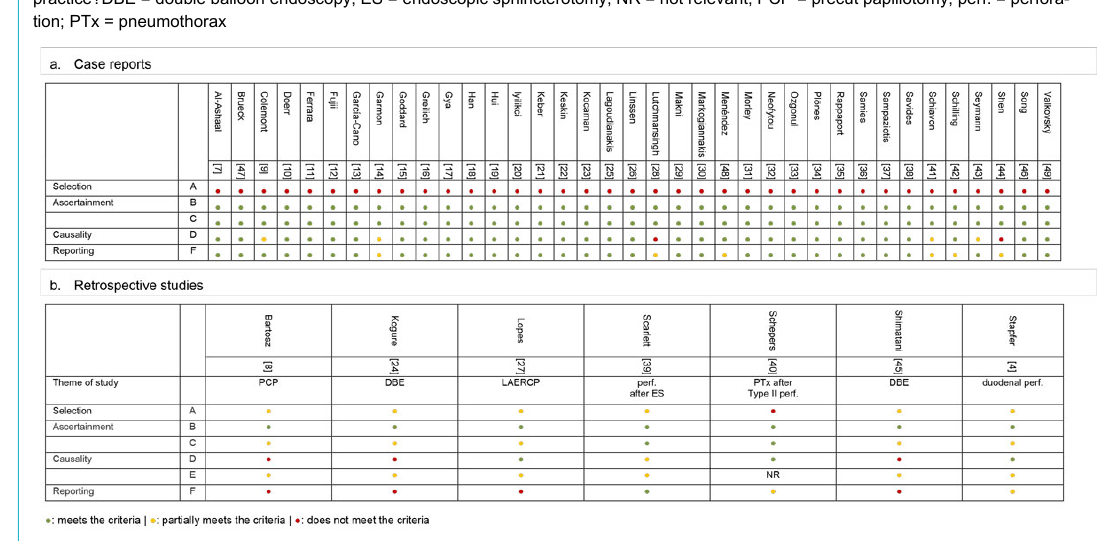
Figure 2: Summary of quality assessment adapted from Murad [5].A: Does the patient(s) represent(s) the whole experience? Might patients with similar presentation not have been reported?B: Was the ERCP adequately ascertained? C: Was the pneumothorax adequately